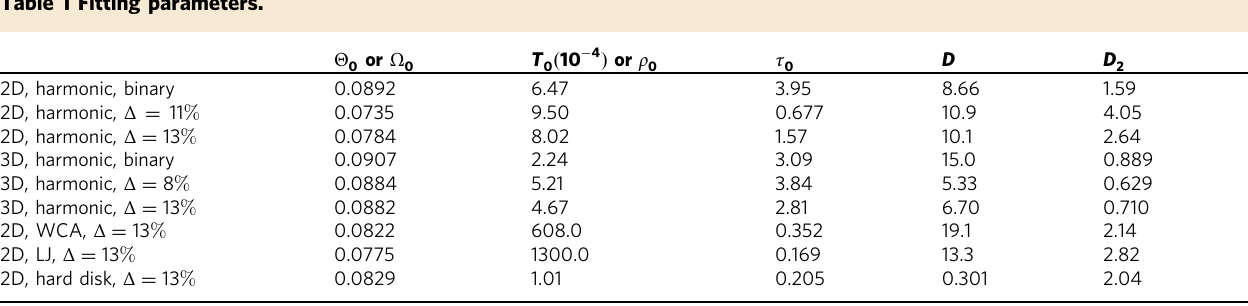
Here we list the fi tting parameters used in the plots according to Eqs. (1) and (2) and in the VFT fi tting of the α relaxation time (Supplementary Fig. 2) for nine major systems under study. The glass transition of hard disk systems is driven by density ρ (or pressure) increase, whereas by temperature T decrease for the rest. Note that the coef fi cient in Eq. (1) can be deduced as κ ¼ D 2 = D . Fitting parameters for additional seven systems used in Fig. 5 are given in Supplementary Table